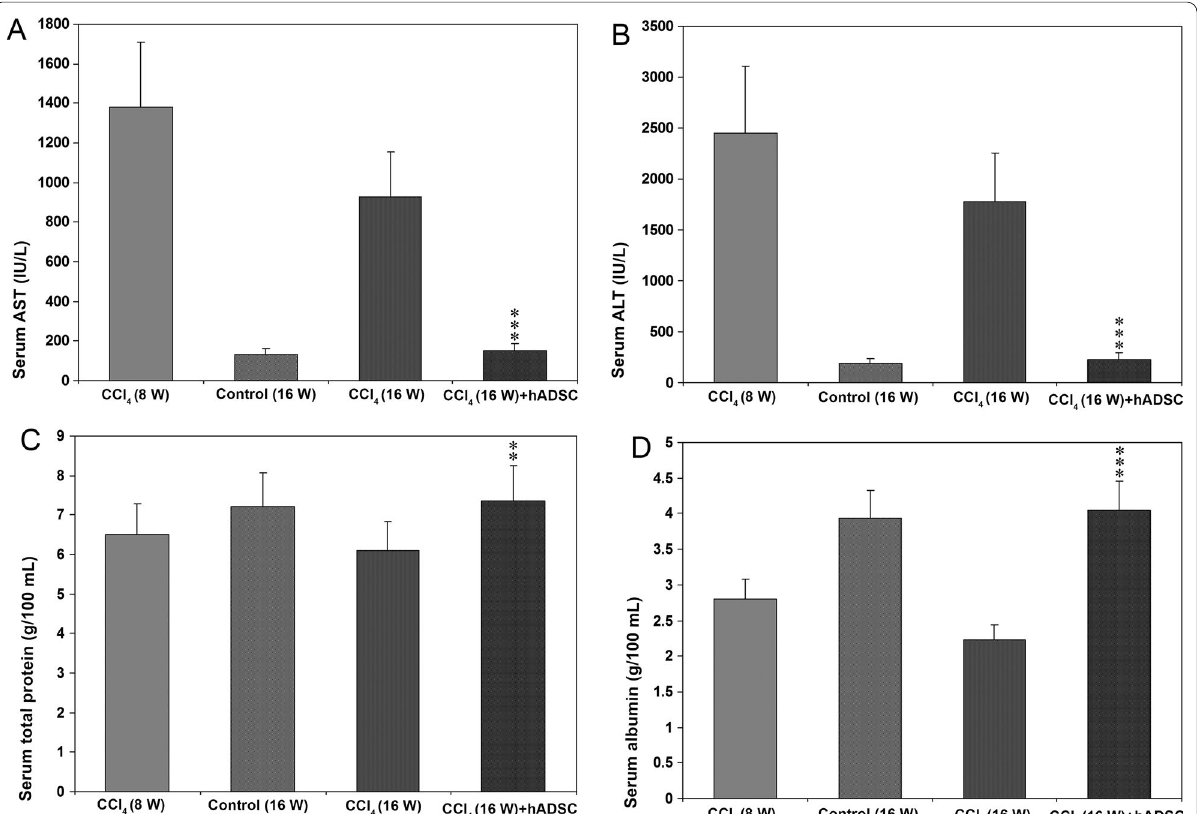
Fig. 3 Aspartate aminotransferase (AST), alanine aminotransferase (ALT), total protein (TP), and albumin levels in the serum following serial administrations of CCl 4 and after treatment with hADSC disc. A AST levels B ALT levels C Serum total protein D Serum albumin. Treatment with hADSC disc resulted in restoration of normal levels of AST, ALT, TP, and albumin in the serum. The data are mean ** P < 0.01 and *** P < 0.001 CCl 4 (16 W) treated group versus CCl 4 (16 W)